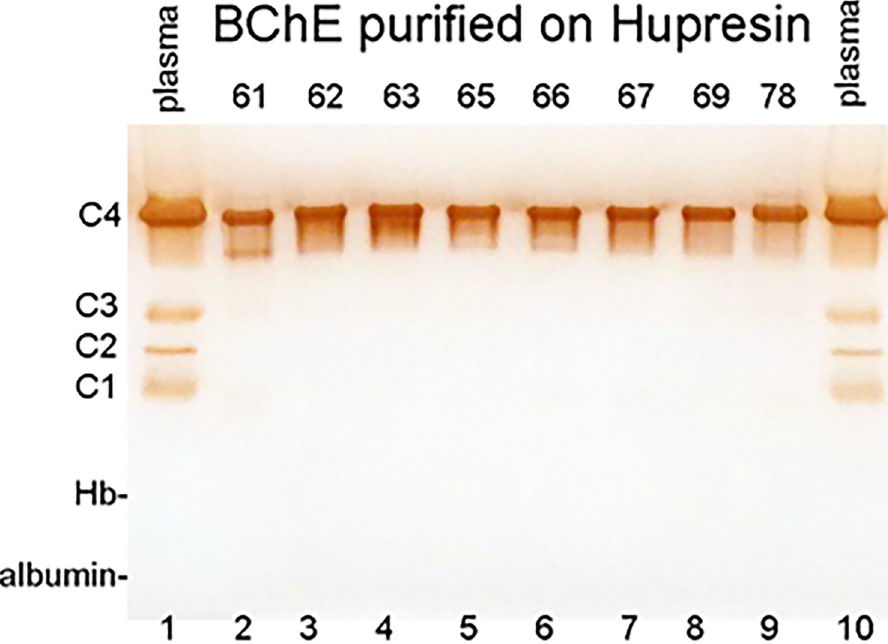
Fig 4. Nondenaturing polyacrylamide gel stained for BChE activity. The pattern of BChE active bands from human EDTA plasma (5 μ L) in lanes 1 and 10 provides a well-established reference for the oligomeric state of BChE, where C1 is monomeric BChE at 85 kDa, C2 is a disulfide crosslinked dimer of BChE and albumin [21], C3 is the BChE dimer at 170 kDa, and C4 is tetrameric BChE at 340 kDa. The nondenaturing gel has an intense C4 band for the BChE tetramer and weak bands for BChE isozymes C1, C2, and C3. BChE purified Cohn fraction IV-4 with Hupresin lot# 61–78 in lanes 2–9 consists predominantly of tetramers. Purified BChE was loaded at 0.01 units (0.02 μ g; 0.23 pmoles) per lane. A red band for hemoglobin (Hb) and a blue band for the albumin-bromophenol blue complex in plasma (lanes 1 and 10) were visible in the unstained gel. Electrophoresis was performed at 200 volts constant voltage for 3.5 h.